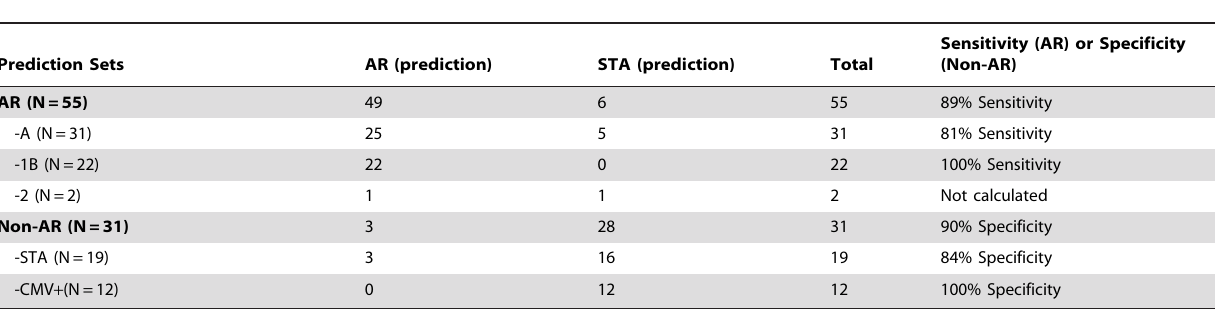
Table 3. Prediction Performance of the Gene-Model on Different Clinical Phenotypes (Biopsy Confirmed).